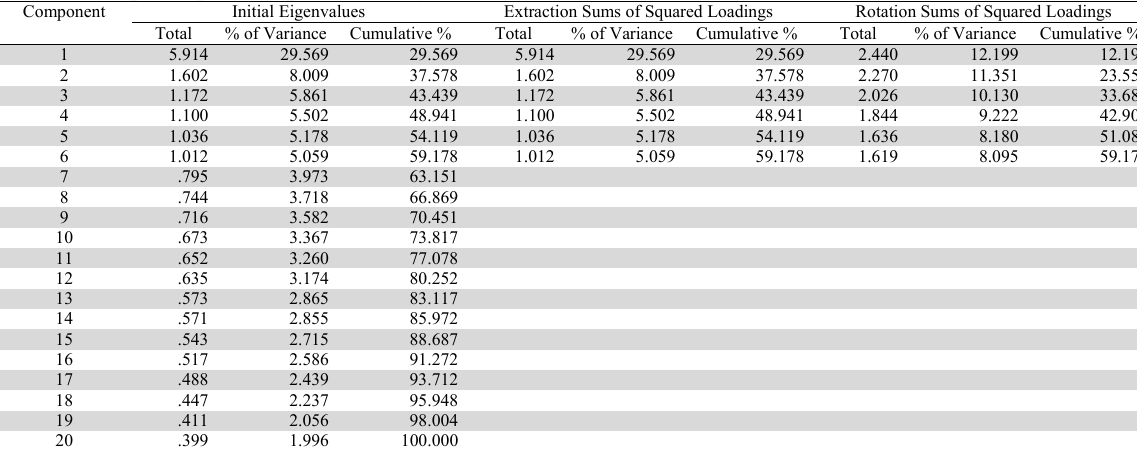
100.000 Extraction Method: Principal Component Analysis. The summary of principle component analysis after rotation Component 1 2